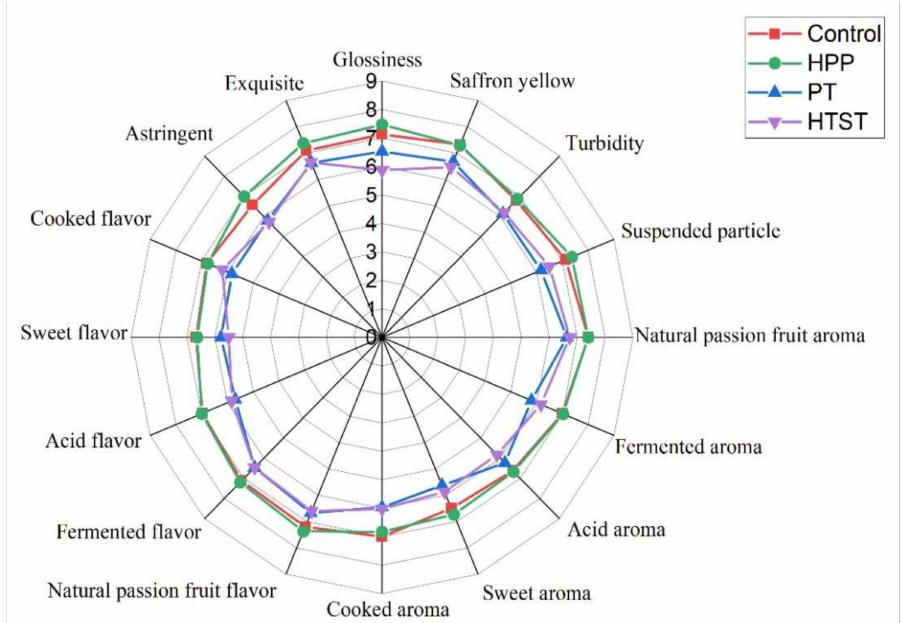
Figure 4. Spider plot of sensory attributes of control, high pressure processing (HPP), pasteurization (PT), and high-temperature short time (HTST))-treated passion fruit pur é